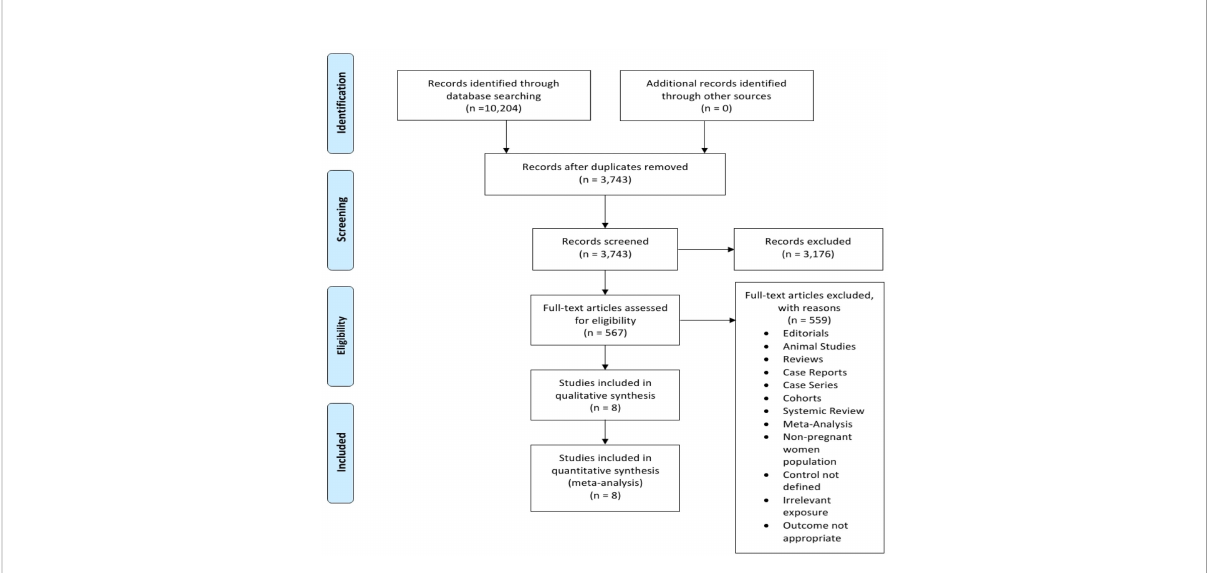
FIGURE 5 A Prisma fl owchart diagram of the initial Literature search.